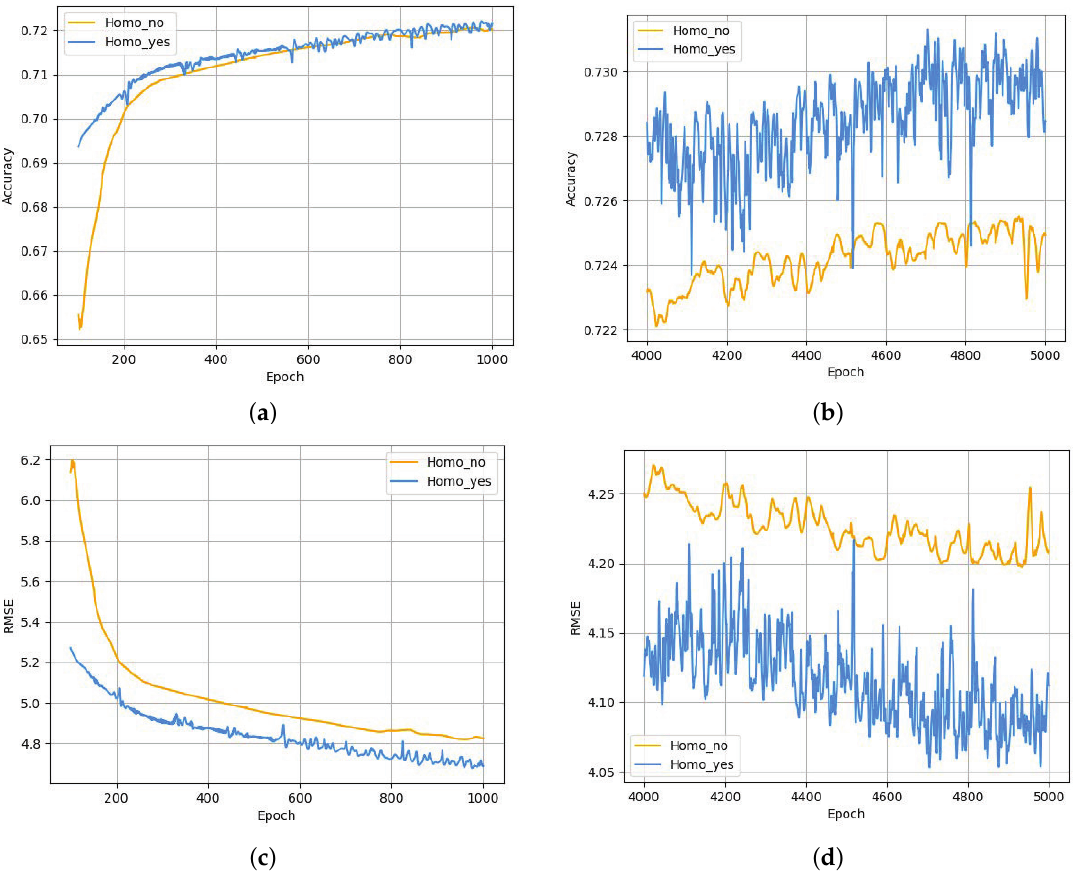
Figure 4. Adding homogeneous adjacency matrices. ( a ) Trend chart of Accuracy for the first 1000 epochs. ( b ) Trend chart of Accuracy for the last 1000 epochs. ( c ) Trend chart of RMSE for the first 1000 epochs. ( d ) Trend chart of RMSE for the last 1000